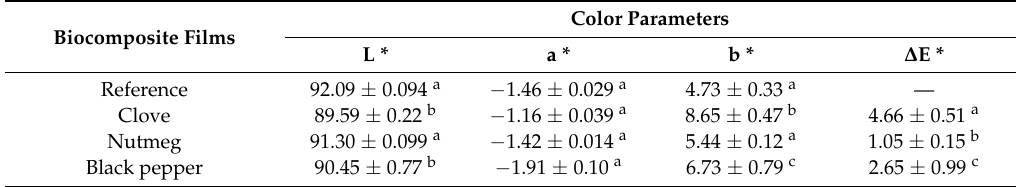
Table 1. CIELab color parameters obtained for biocomposite